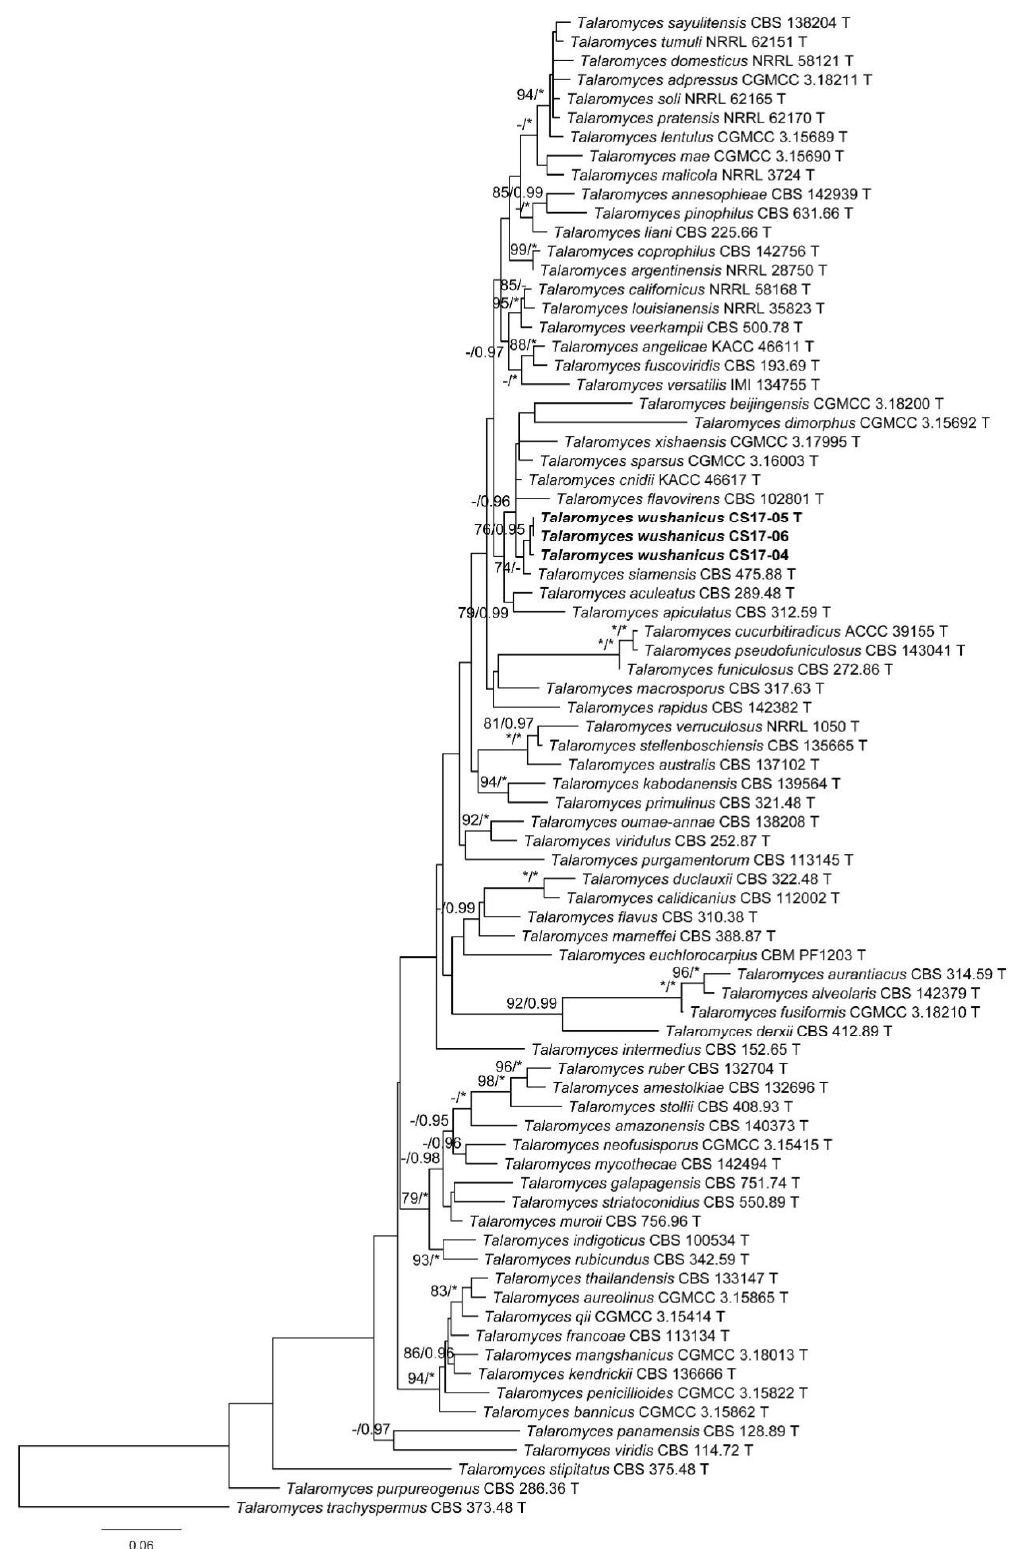
Figure 4. Maximum likelihood phylogeny of Talaromyces sect. Talaromyces inferred from the BenA dataset. Bootstrap values ≥ 70% ( left ) or posterior probability values ≥ 0.95 ( right ) are indicated at nodes. Asterisk denotes 100% bootstrap or 1.00 posterior probability.